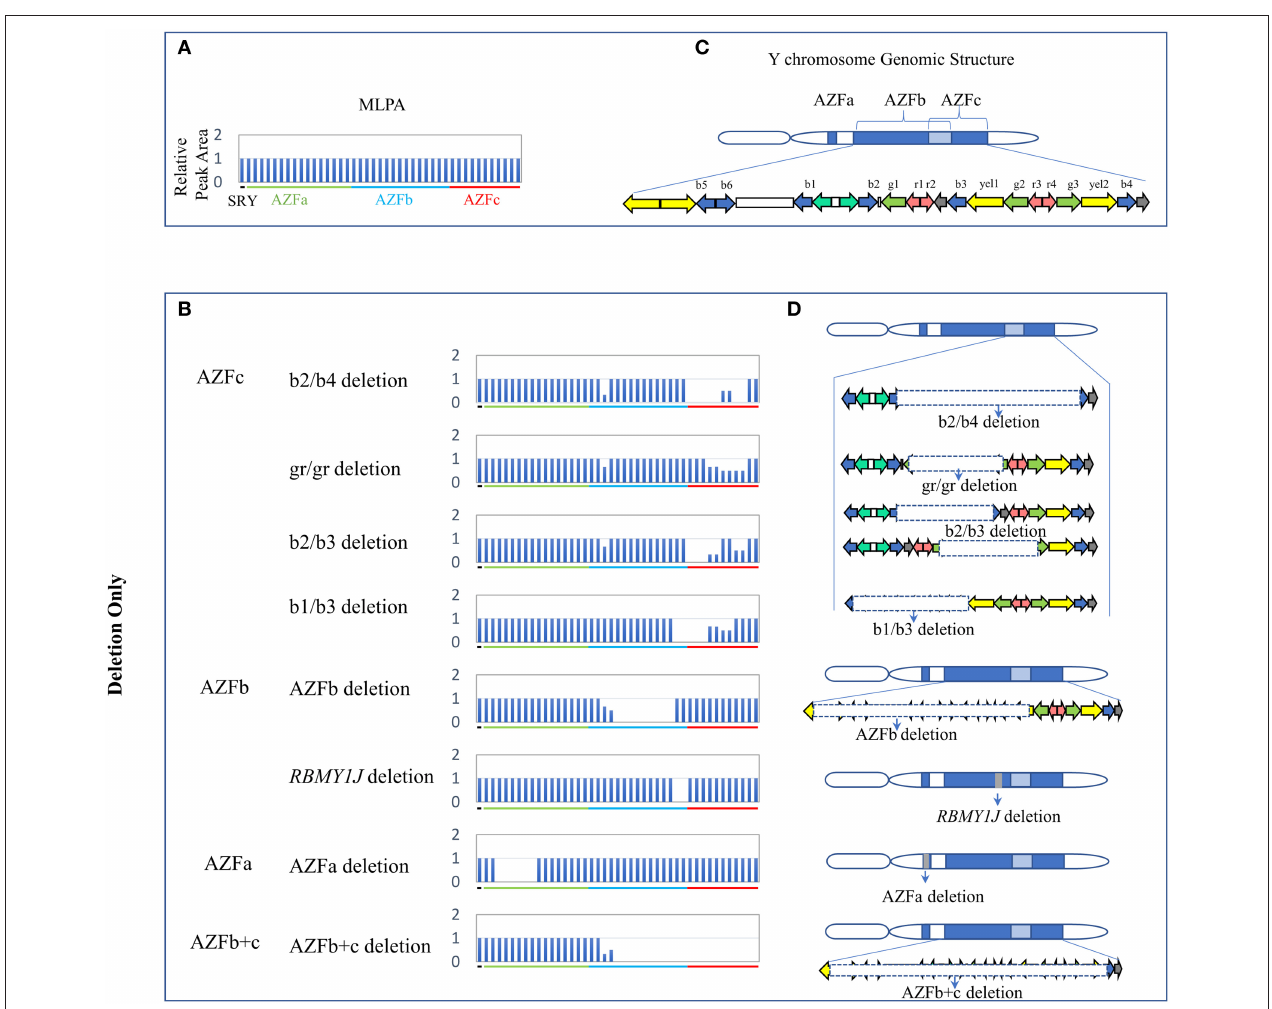
FIGURE 1 | CNVs (Deletion Only) in AZF regions of the human Y chromosome identified by MLPA. (A,B) Results of MLPA analysis. The relative peak area of each probe was calculated by dividing the actual peak area of the subject by the average of that of five reference samples. Decreased relative peak areas mean copy-number deletion. (C,D) Corresponding structures and rearrangements of AZF regions.